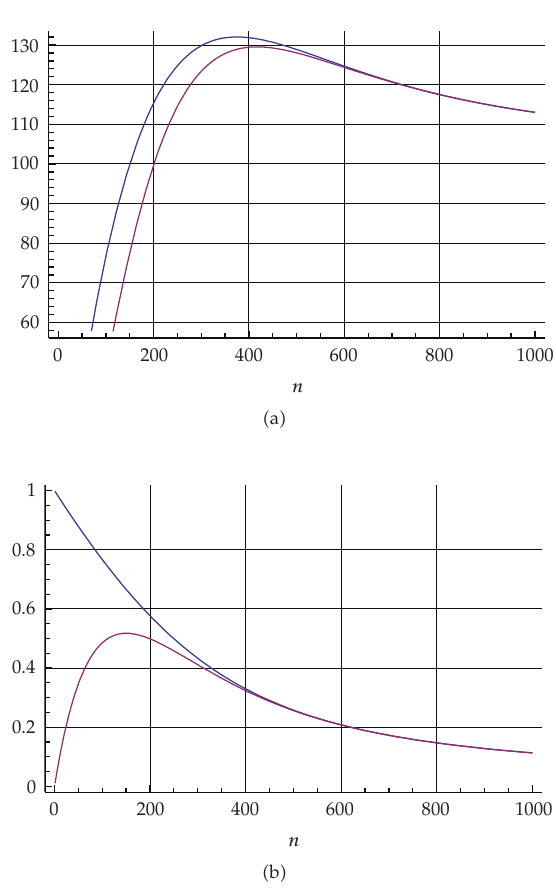
Figure 2: (cid:2) a (cid:3) G a (cid:2) in red (cid:3) and G r,a (cid:2) in blue (cid:3) for p (cid:5) 0 . 01, as given by (cid:2) 2.11 (cid:3) and (cid:2) 3.7 (cid:3) , respectively. (cid:2) b (cid:3) F r (cid:2) in blue (cid:3) and F (cid:2) in red (cid:3) for p (cid:5) 0 .